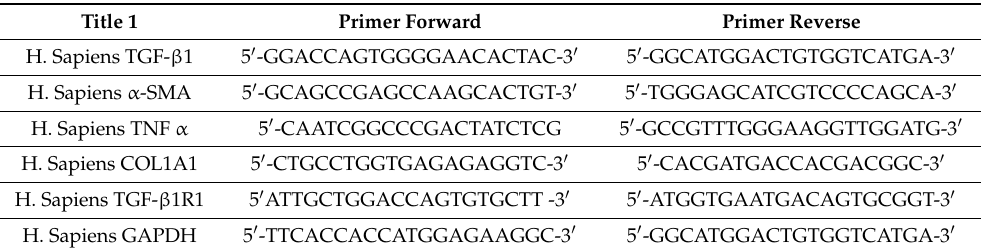
Table 1. Summary of primers used for quantitative PCR